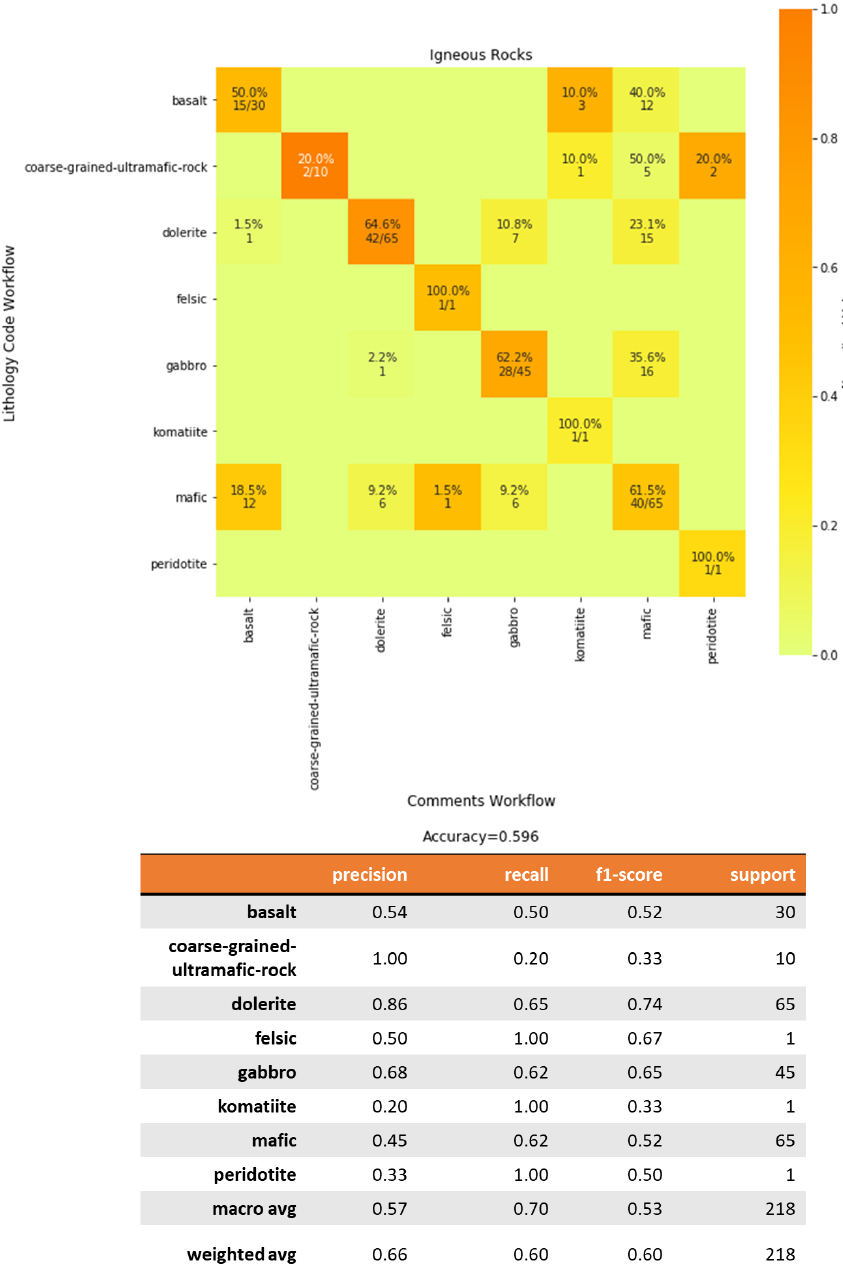
Figure 8. Confusion matrix for igneous rocks comparing the fuzzy string matching results from the Lithology_Code workflow (vertical axis) and Comments workflow (horizontal axis). The heatmap shows the values normalized to the support size to address the imbalance between classes. The values shown in the cells indicate the number of samples classified for the class. Empty cells indicate zero samples.